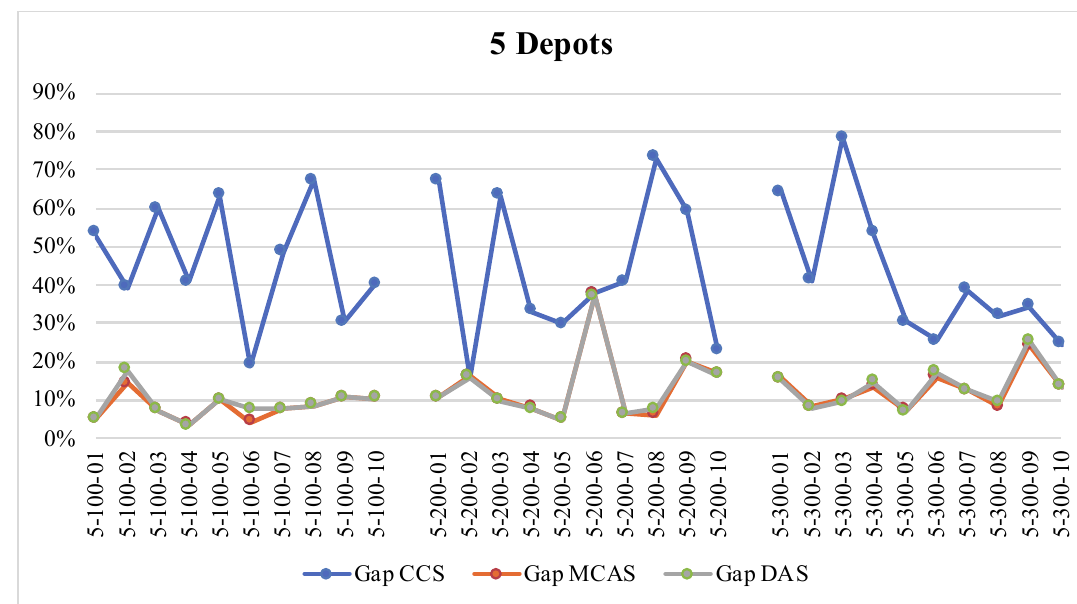
Fig. 13. Gap constructive procedures vs. optimal solution (5